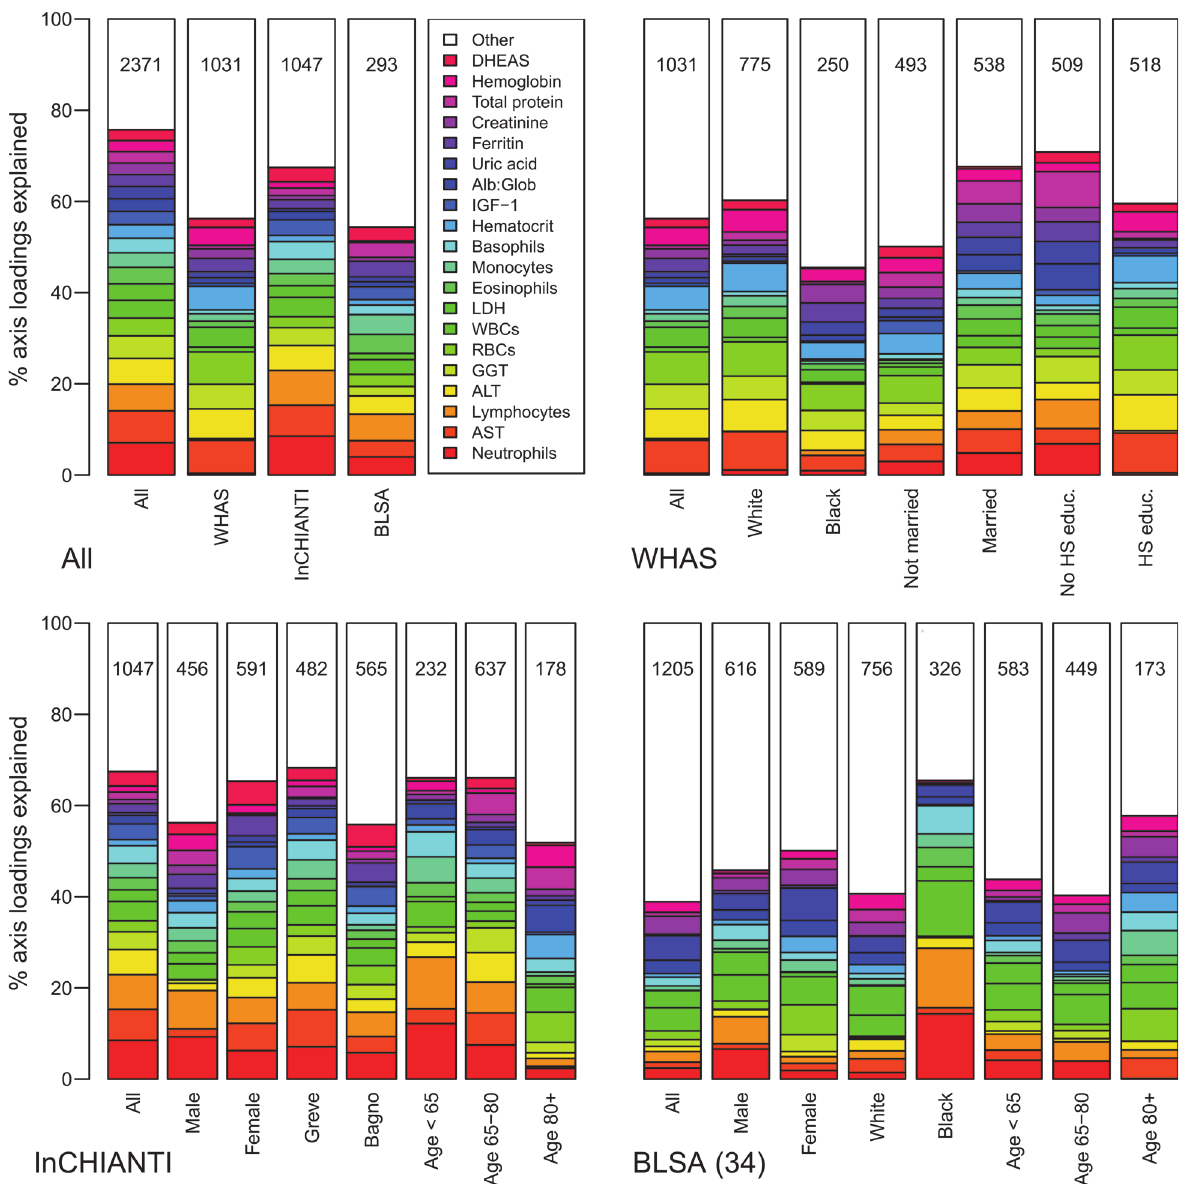
Fig 4. Biomarker loading order and stability for PCA3 across data sets and subsets. Loading importance is calculated as the loading divided by the sum of the absolute values of all loadings. These values are ordered from high (red, on bottom) to low (magenta, on top) for the first 20 loadings; remaining loadings are grouped together as “ Other ” in white. Accordingly, neutrophils have the strongest loading, then AST, then lymphocytes, etc. The order and colors are derived from the full analysis combining the three data sets (left column, top-left panel “ All ” ) and applied to all other columns in the figure. Stability of loadings is indicated by conservation of loading heights across bars. For each panel, the loadings for the full data set are at left. Numbers indicate subset sample sizes. For all panels except BLSA, the 43-variable set is used; for BLSA there was insufficient sample size to perform PCA on subsets with 43 variables, so the 34-variable analysis is